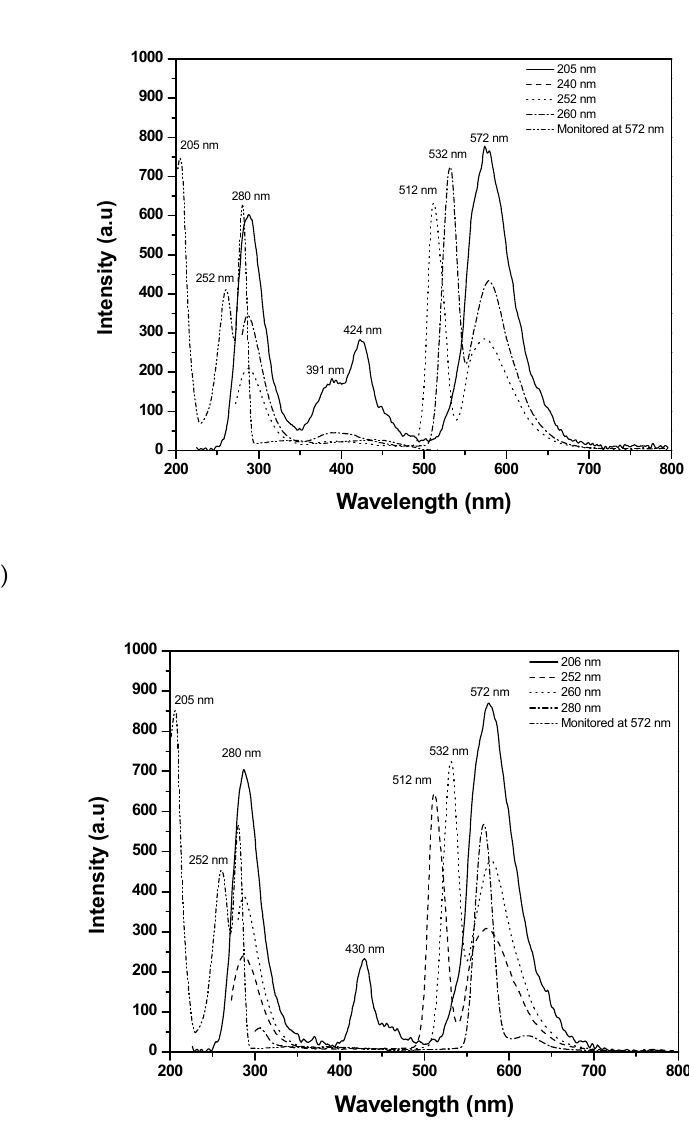
Figure 12. Emission spectra of ( a ) EV6Cl and ( b ) EV6 in methanol at various excitation wavelengths.